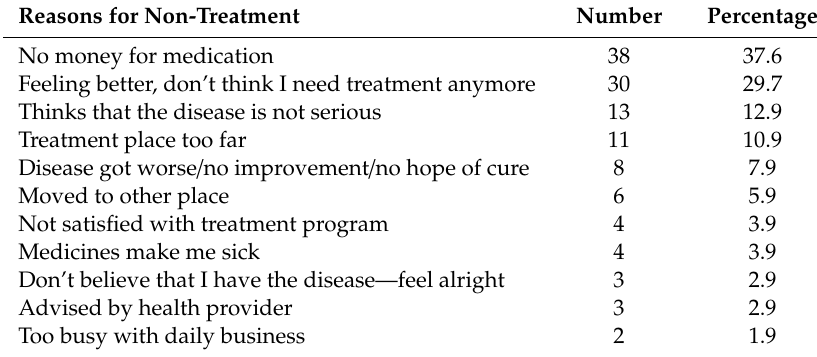
Table 3. Reasons for not being on treatment ( N =